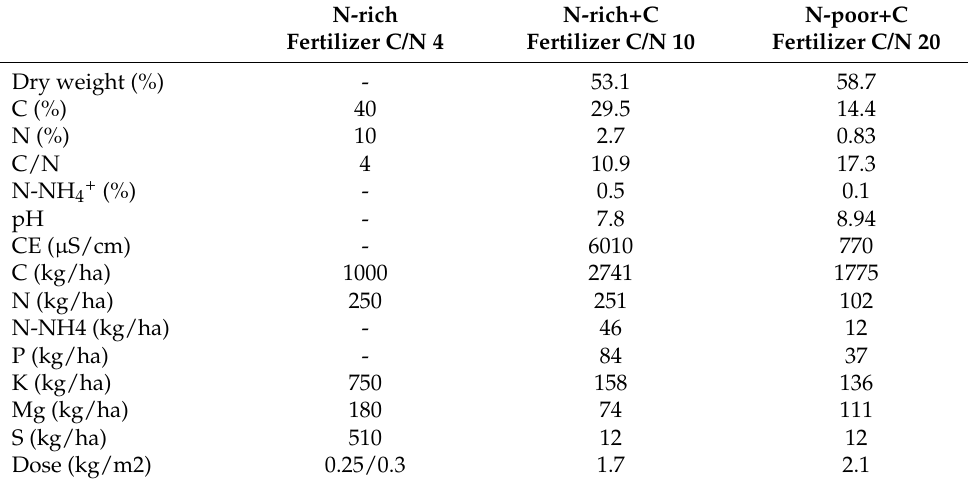
Table 2. Chemical composition of each fertilizer and contributions of C and nutrients in each treatment.